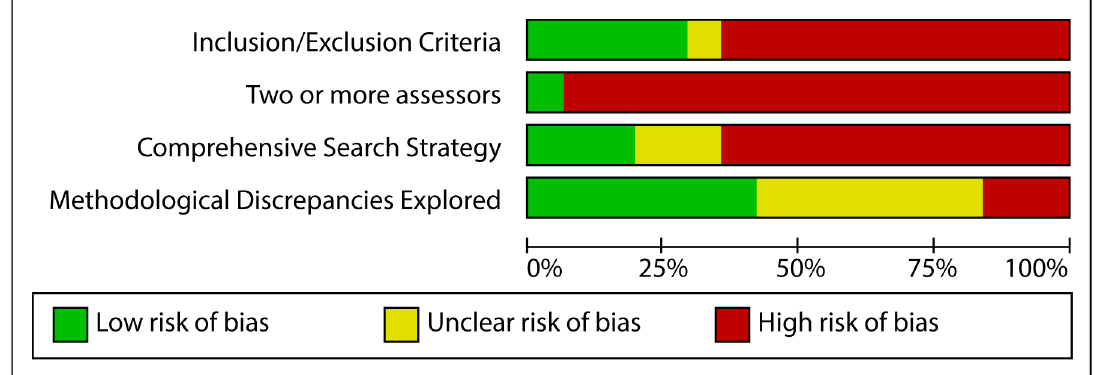
Fig 2. Risk of bias graph: review authors' judgments about each risk of bias item presented as percentages across all included studies